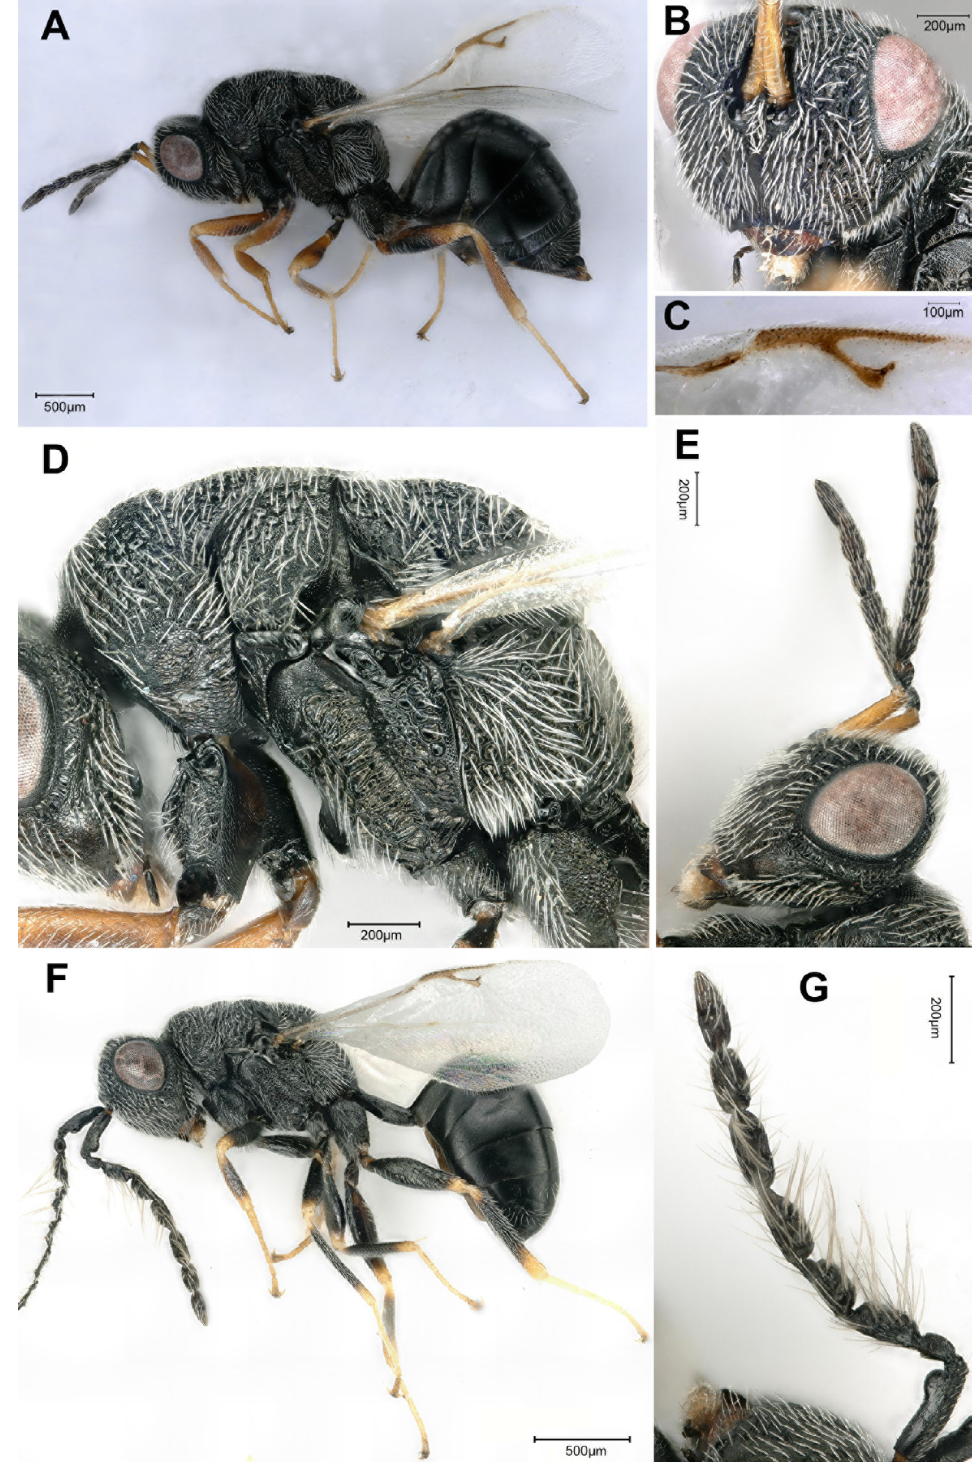
Fig. 8. Aximopsis deserticola (Zerova, 2004) comb. nov. A . Female in lateral view. B . Head of female in frontal view. C . Fore wing venation. D . Mesosoma in lateral view. E . Head and antennae in lateral view. F . Male in lateral view. G . Male